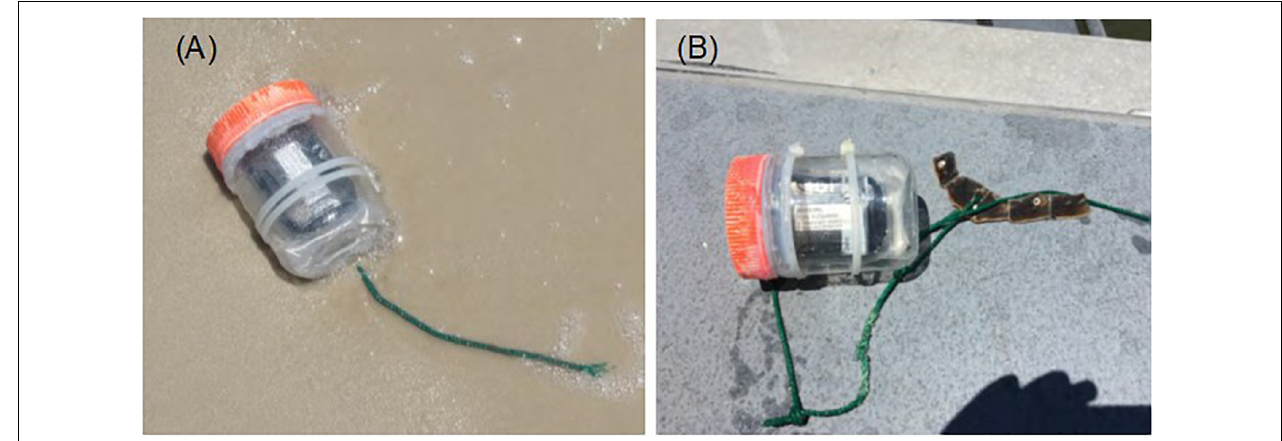
FIGURE 3 | (A) Example of beached jar with the twine still attached but broken prior to where a carcass was attached. These carcasses are presumed to have been scavenged prior to the jar beaching. There are no instances where a jar broke free from an effigy. (B) Example of beached jar with a portion of the rear carapace remaining attached to the twine. These carcasses are presumed to have decomposed prior to the jar